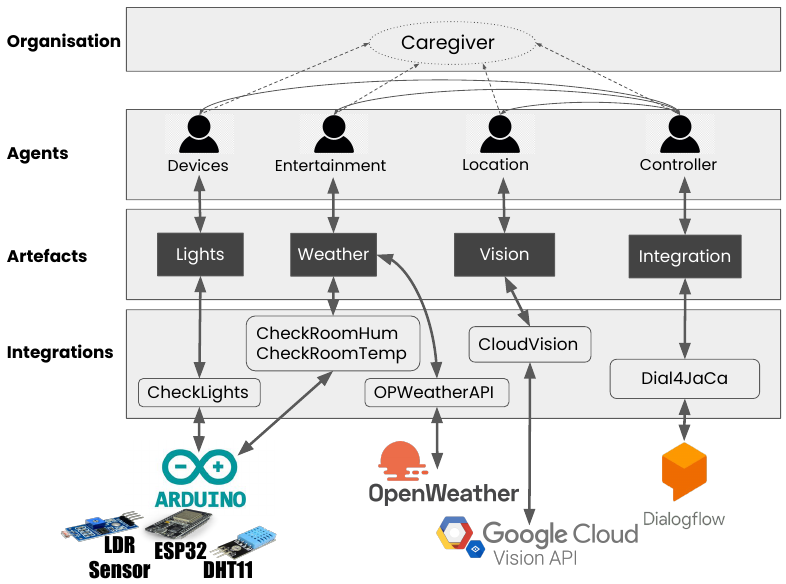
Figure 3. Multi-agent system